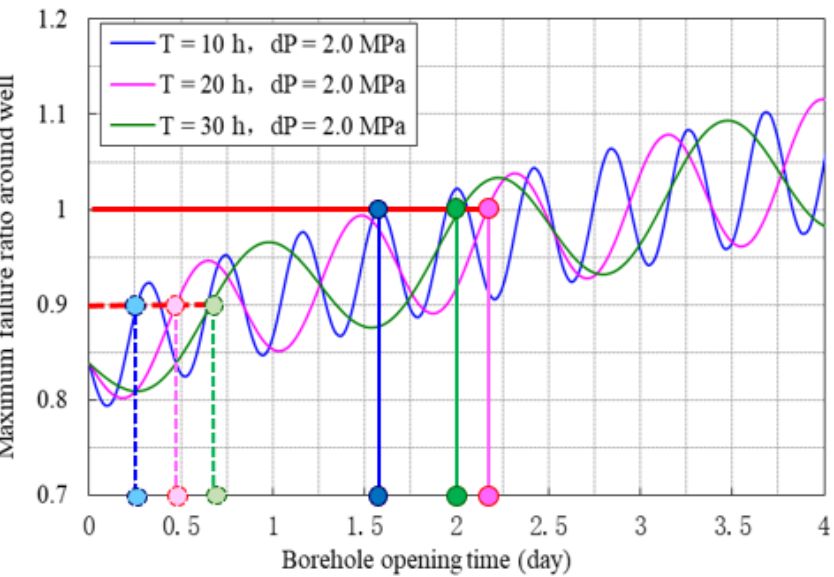
Figure 7. Formation maximum failure ratio change under pressure variation (constant amplitude).